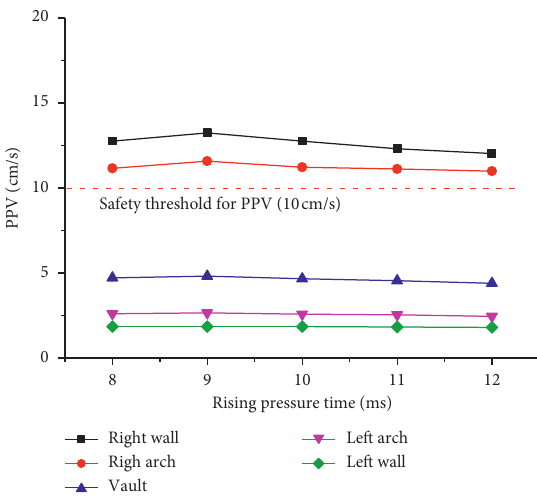
Figure 12: Changes of maximum PPV with cohesion.